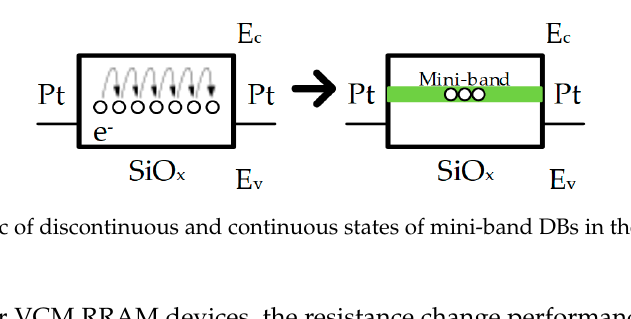
Figure 4. Schematic of discontinuous and continuous states of mini-band DBs in the middle of silicon oxide band gap.